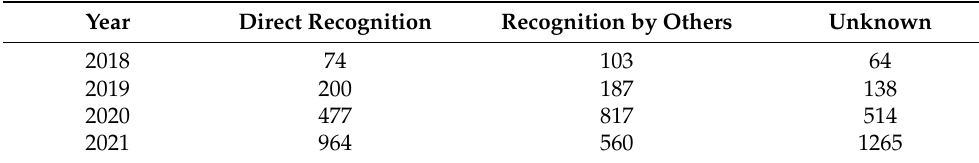
Table 5. Route of Damage Recognition by Year.